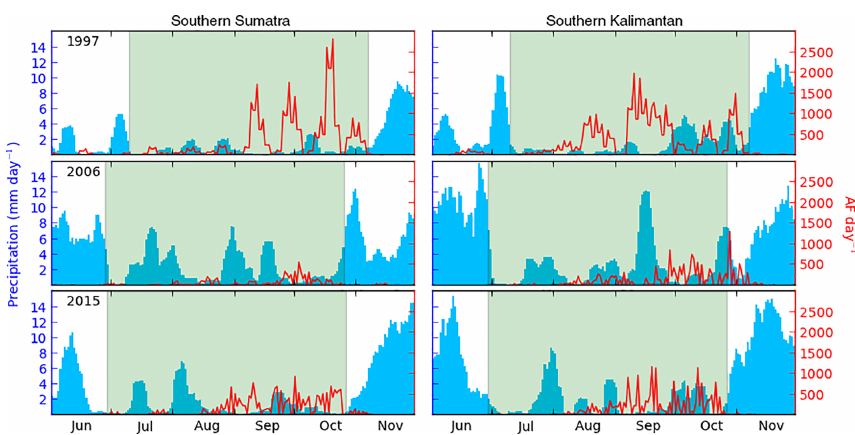
Figure 6. Daily active fire (AF) detections (red) and rainfall (blue) in southern Sumatra and southern Kalimantan during dry seasons of 1997, 2006, and 2015. The green shaded area indicates the dry season defined here as the 120 day period with lowest rainfall.